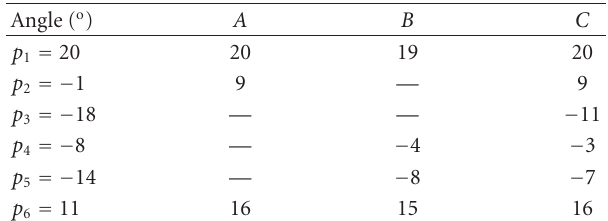
Table 8: Validation results for orientation in degrees ( ◦ ), using mobile object